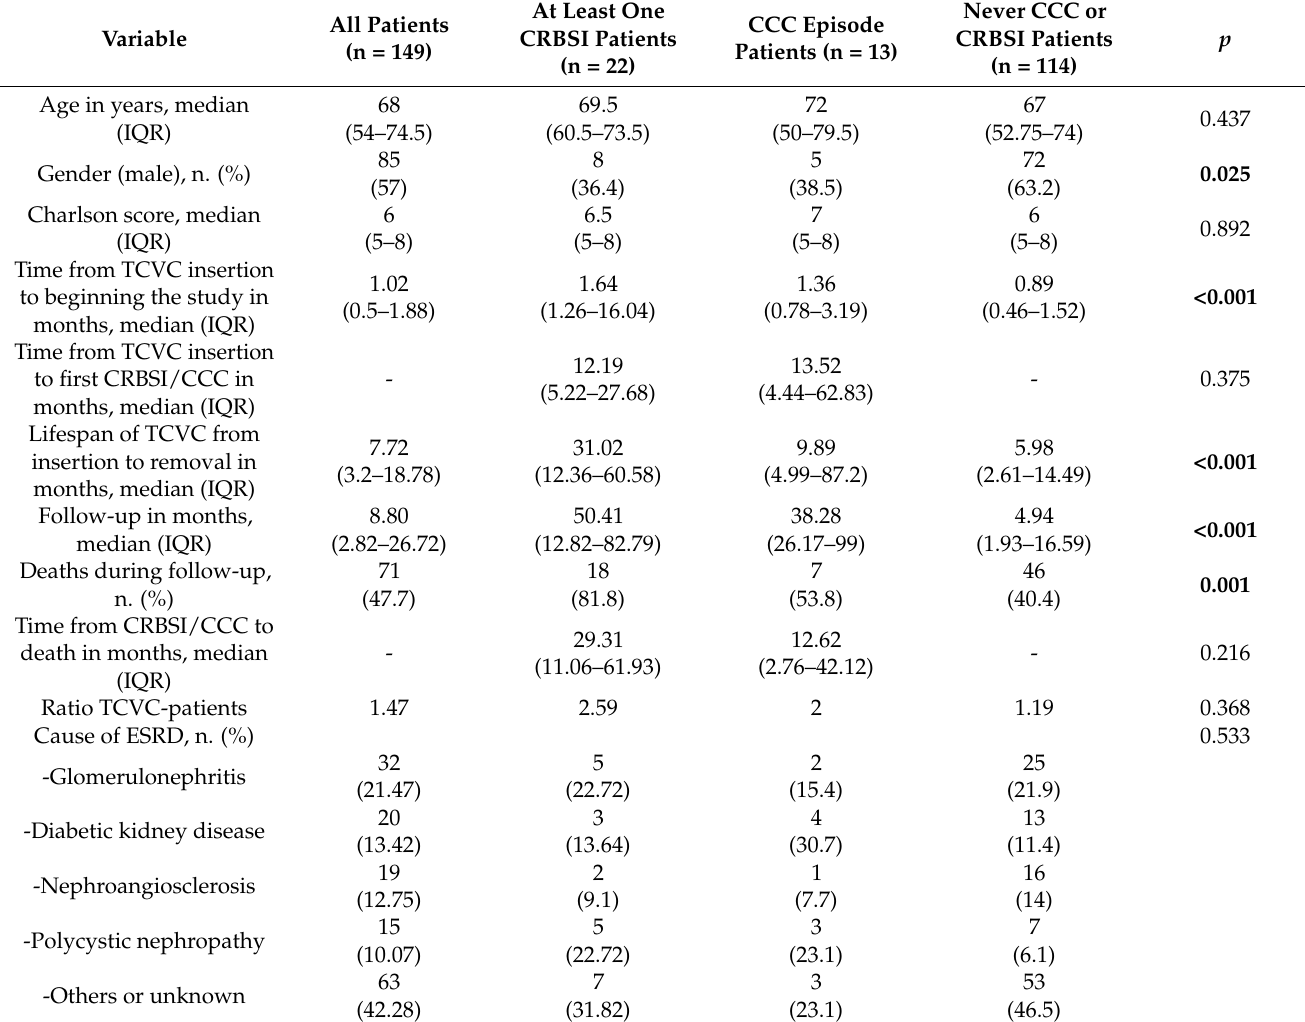
Table 2. Characteristics of patients by quantitative blood culture